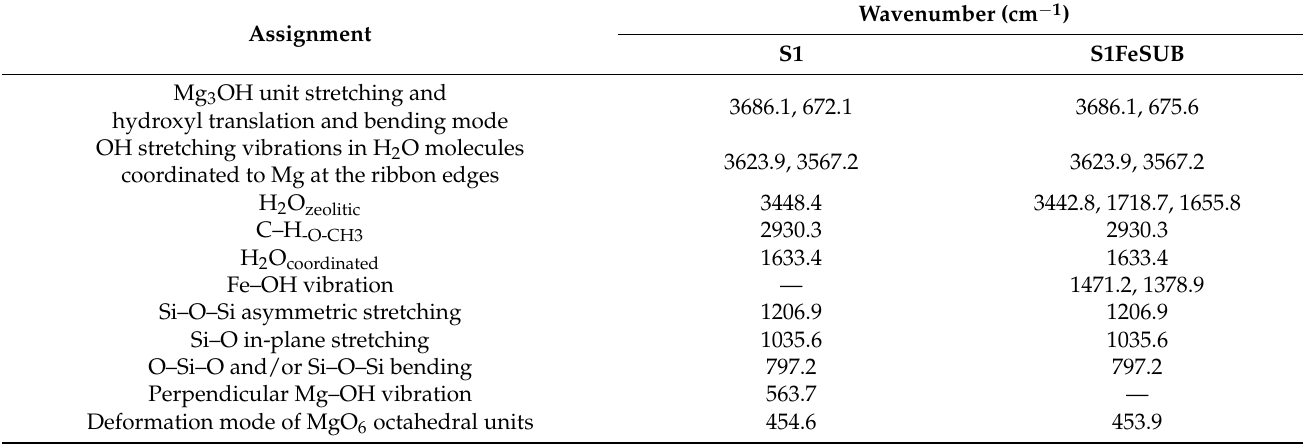
Table 2. Detail of FTIR band assignment for the S1 and S1FeSUB